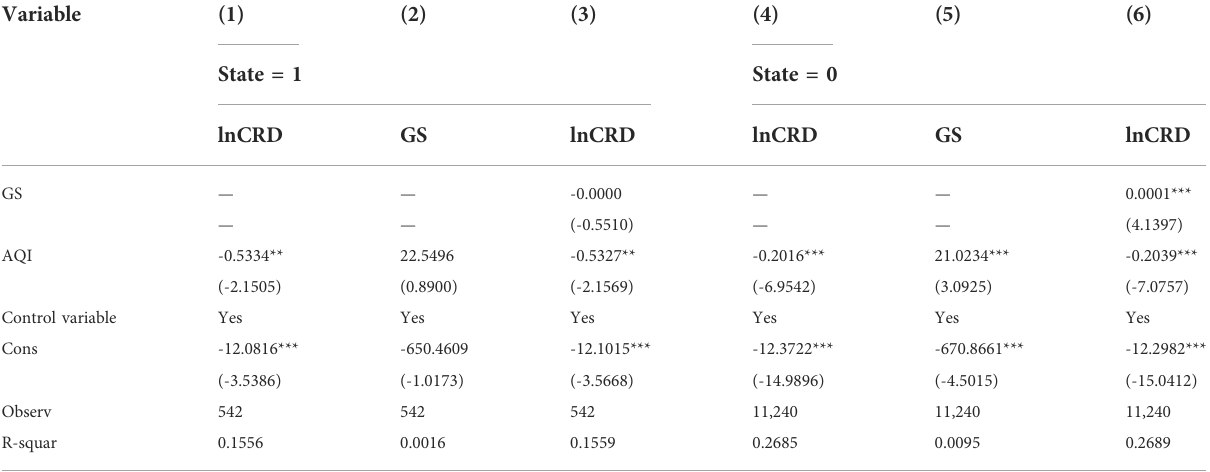
TABLE 9 Heterogeneity analysis of enterprises based on the government concern.